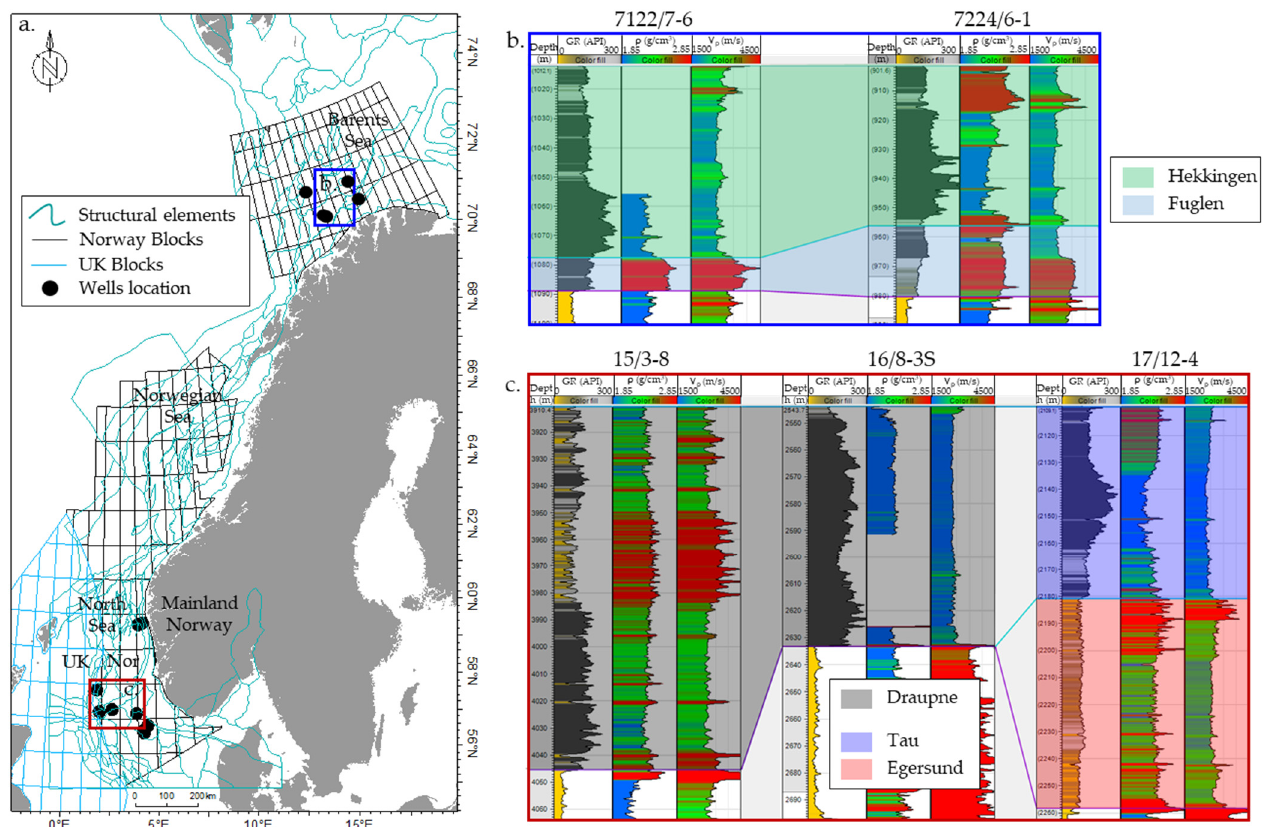
Figure 1. Map represents the structural elements (green), blocks (black and blue lines) and studied wells (black dots) location on the Norwegian Continental Shelf (NCS) ( a ). Two well correlations with wireline logs (i.e., GR, density and p-velocity) of primary caprocks are presented where (b) represents the Barents Sea wells, and ( c ) indicated wells from the North Sea. The wireline logs illustrated significant variation of vertical caprock properties as well as difference between wells. Please note that well sections are flattened using the top of the caprocks (i.e., top Hekkingen, Draupne, and Tau formations).